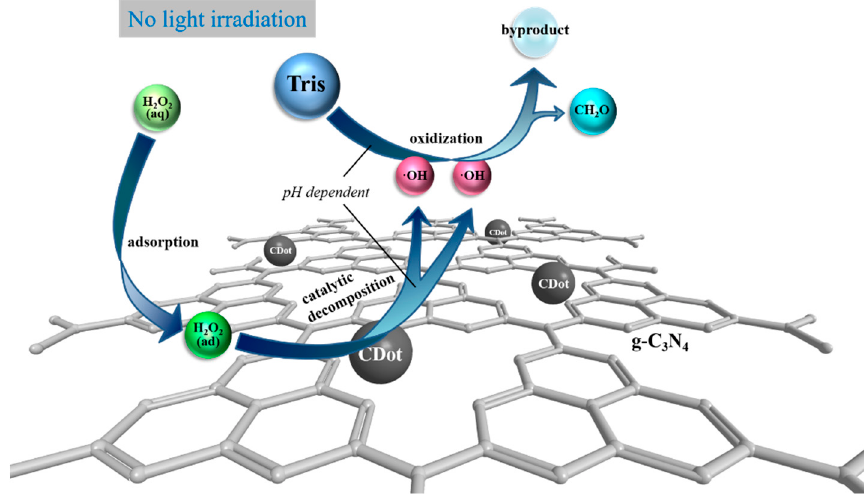
Figure 7. The mechanism of catalytic decomposition of H 2 O 2 on CDots/g-C 3 N 4 composite.